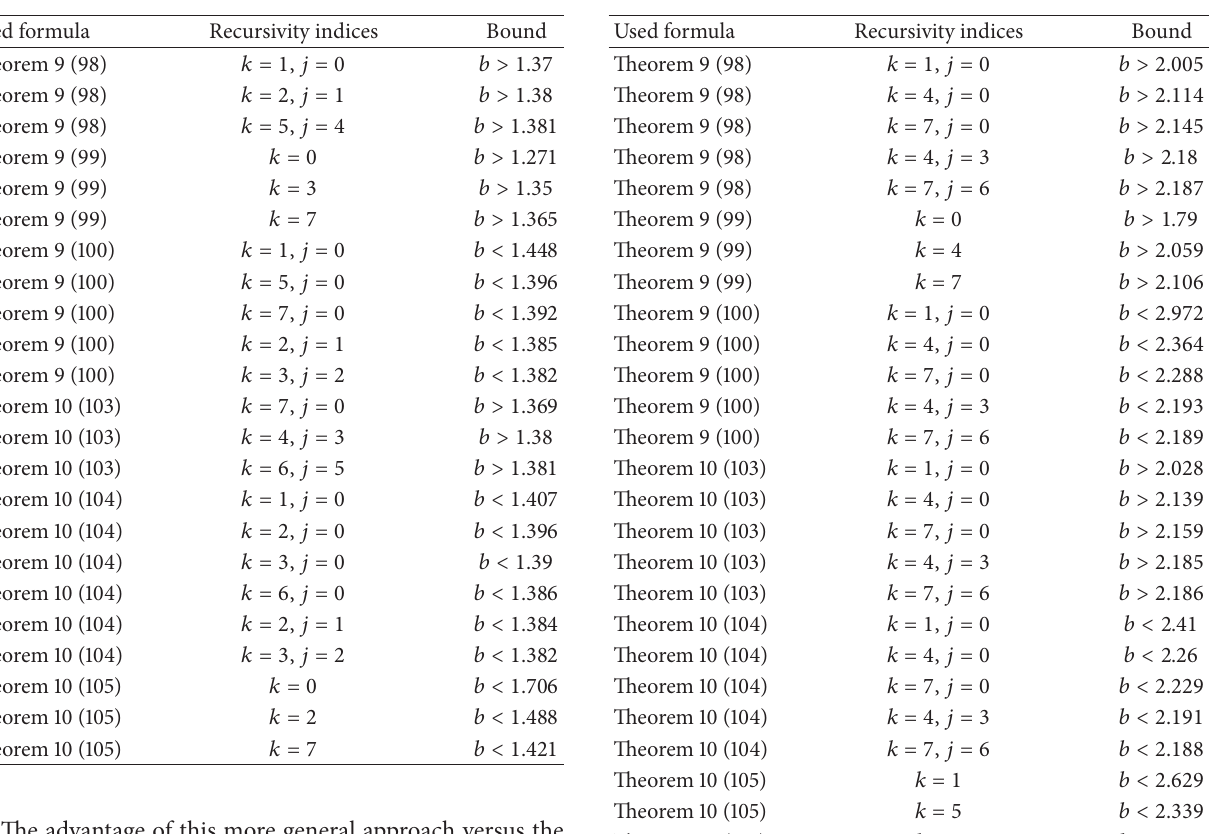
Table 3: Comparison of bounds for 𝑏 in Example 3. Table 4: Comparison of bounds for 𝑏 in Example